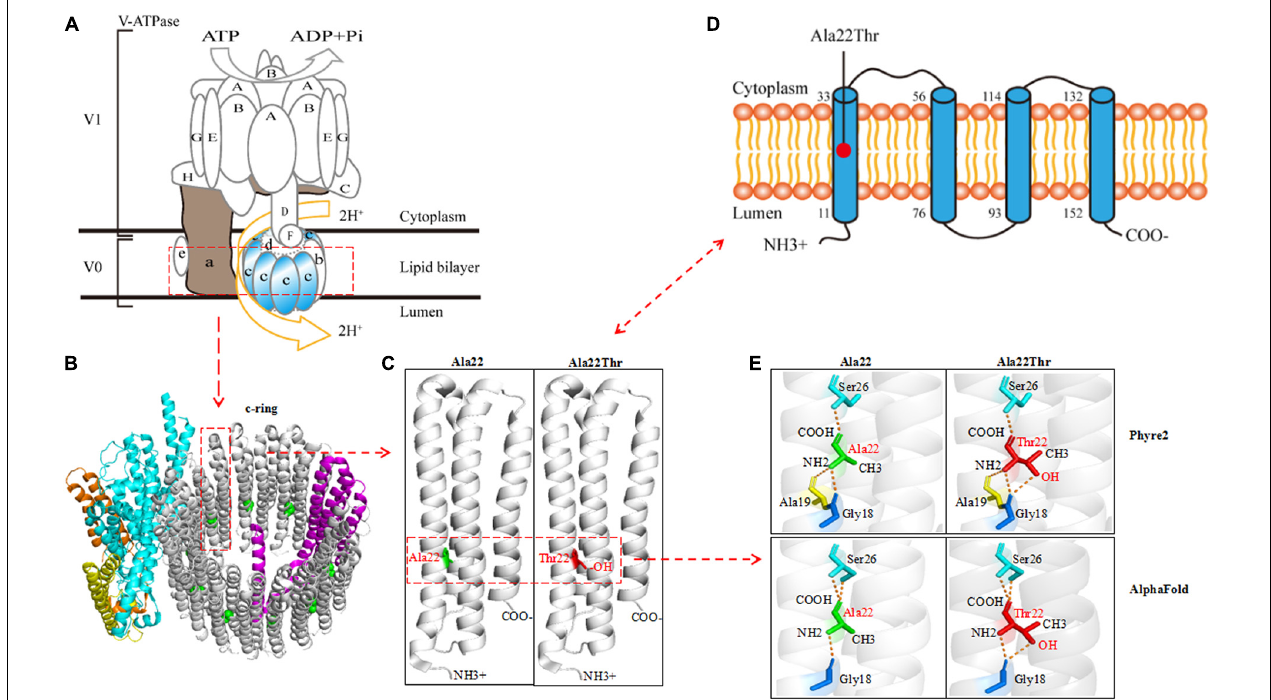
FIGURE 2 | Schematic illustration of the ATP6V0C protein and molecular effect of Ala22Thr on ATP6V0C protein. (A) Structure diagram of major molecular components of vacuolar ATPase (V-ATPase), which is composed of a cytosolic V1 domain and a transmembrane V0 domain. The V0 domain consists of five different subunits: a, b, c, d, and e. The proteolipid c-ring was comprised of nine c-subunits (ATP6V0C protein) and one b-subunit. The “c-ring” couples the energy generated by ATP hydrolysis to the translocation of protons from the cytosol to the lumen through the hemichannel formed between the a-subunit and the proteolipid c-ring. (B) Three-dimensional (3D) structure of the V0 domain. (C) The focal structure of ATP6V0C protein. Ala22Thr was located in the first transmembrane domain of ATP6V0C protein with an addition of hydroxide radical. (D) The commonly used topographical diagram showing the five topological domains and the four transmembrane domains. (E) Left: residue Ala22 formed three hydrogen bonds with Gly18, Ala19, and Ser26 in Phyre2; AlphaFold showed that residue Ala22 formed three hydrogen bonds, one with Gly18 and two with Ser26. Right: both predictions showed that a novel hydrogen bond with Gly18 was formed when alanine at residue Ala22 was substituted by threonine. Furthermore, the Ala22Thr lead to a new addition of hydroxide radical that potentially influence the proton transport in the proteolipid c-ring of the